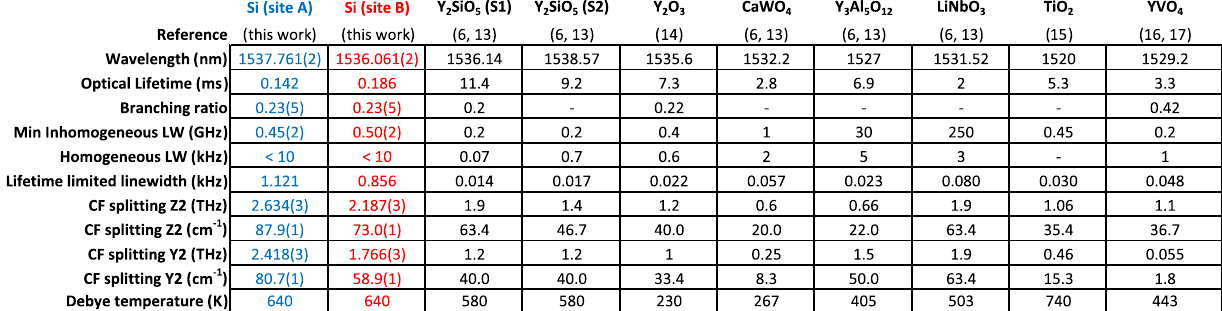
FIG. 18. Comparison of the key parameters of erbium dopants in various hosts. Sites A and B studied in this work exhibit the largest CF splittings and the fastest radiative decay, offering unique promise for quantum